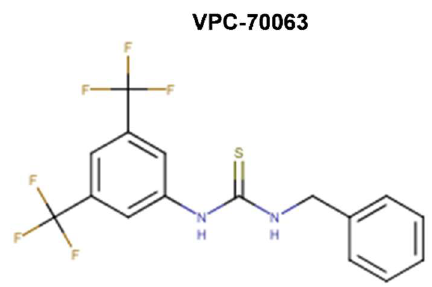
Figure 11. Chemical structure of VPC-70063 identified in silico by screening of the largest purchasable chemical space of the ZINC database that targets a novel binding site located at the Myc-Max/DNA interface of the 1NKP Myc-Max X-ray structure. See subsection 3.1.4 for further details.